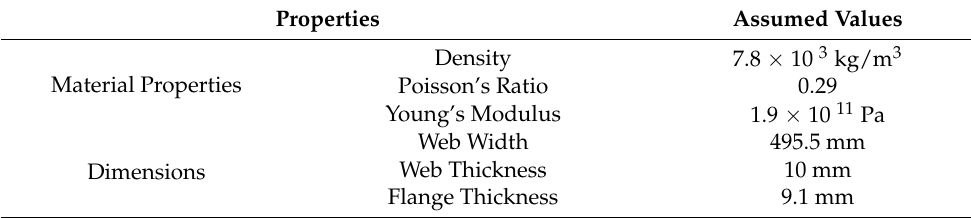
Figure 2. U-pile dimensions used for generating the dispersion curves and numerical models. Table 1. Material properties used to generate the dispersion curves using GUIGUW.